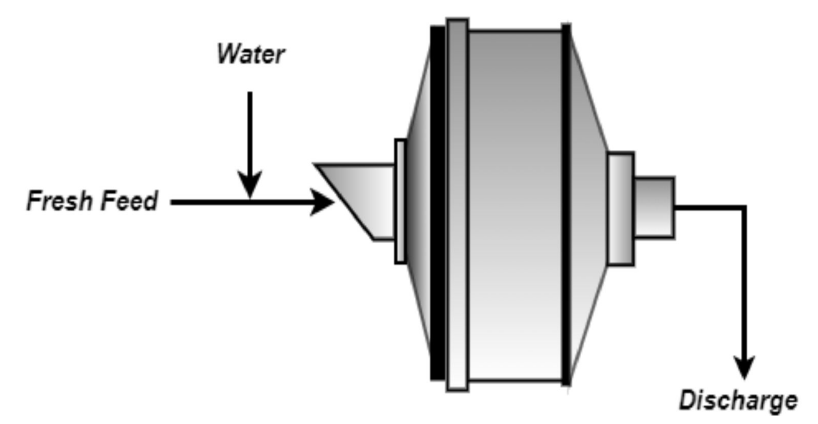
Figure 2. Schematic representation of an SAG